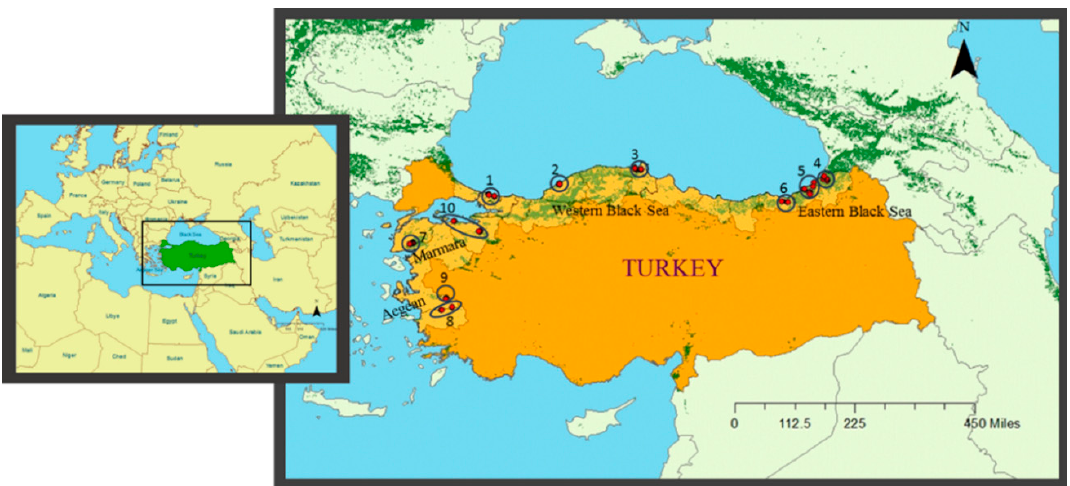
Figure 1. Turkey and distribution of hardwood forest in Turkey (derived from Food and Agriculture Organization (FAO) Data in Arc Map). All evaluated sites are indicated with site numbers and province borders. Study sites were located in the following provinces: (1) ¸Sile, (2) Zonguldak, (3) Sinop, (4) Artvin, (5) Rize, (6) Trabzon, (7) Çanakkale, (8) Aydın, (9) ˙Izmir, and (10)